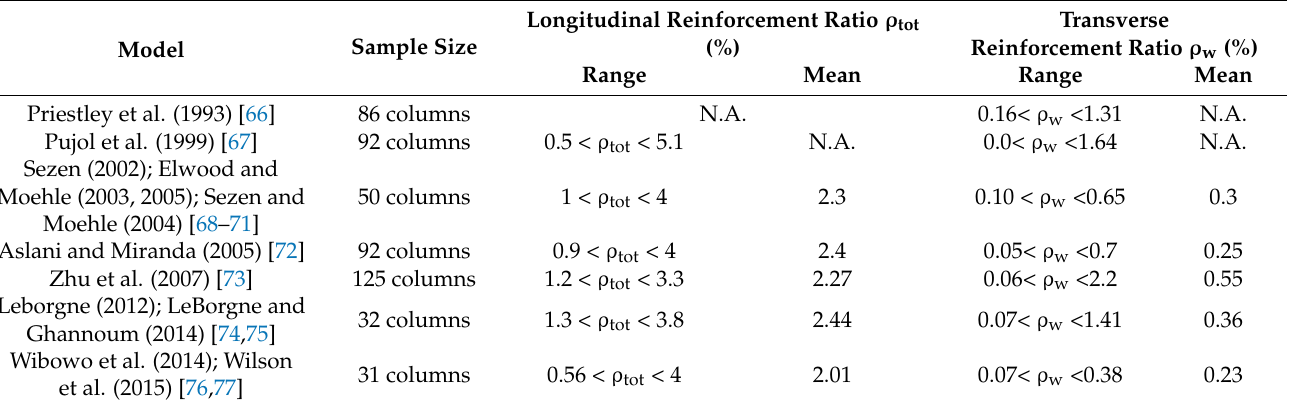
Table 15. Ranges of longitudinal and transverse reinforcement ratios of experimental databases (adapted from